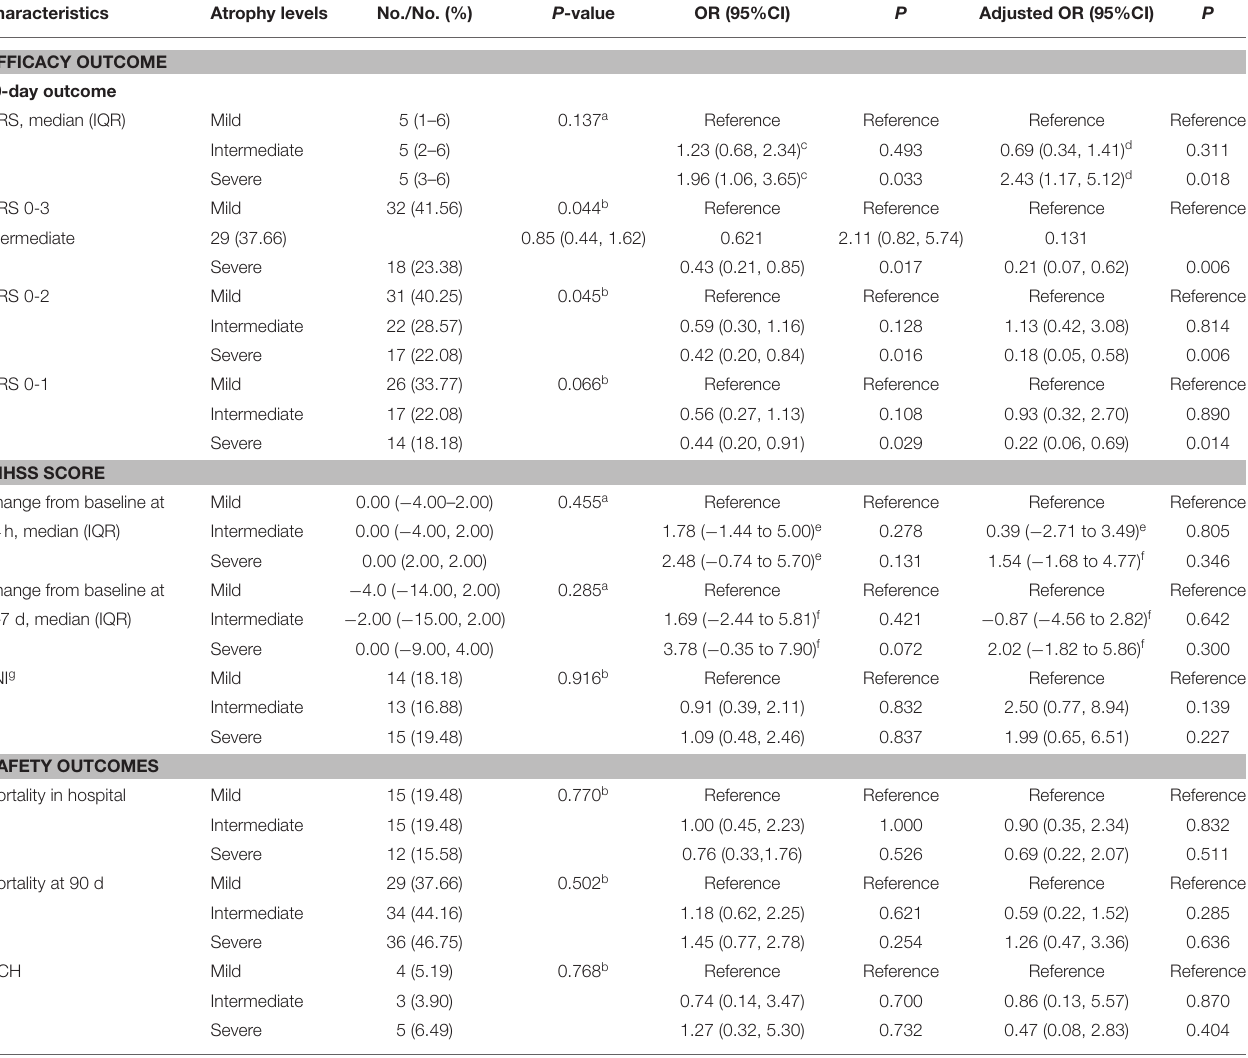
TABLE 3 | The impact of brain atrophy on clinical outcome. Characteristics Adjusted OR